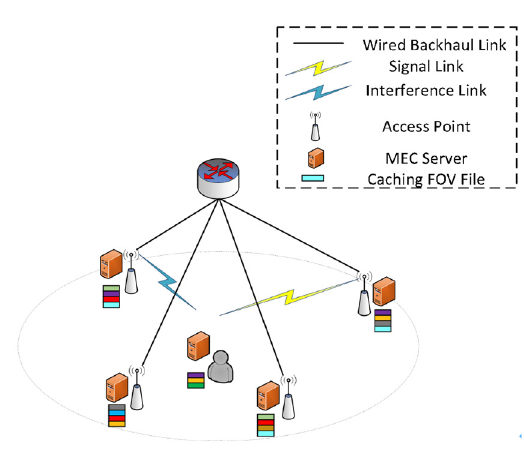
Figure 1. VR network architecture.